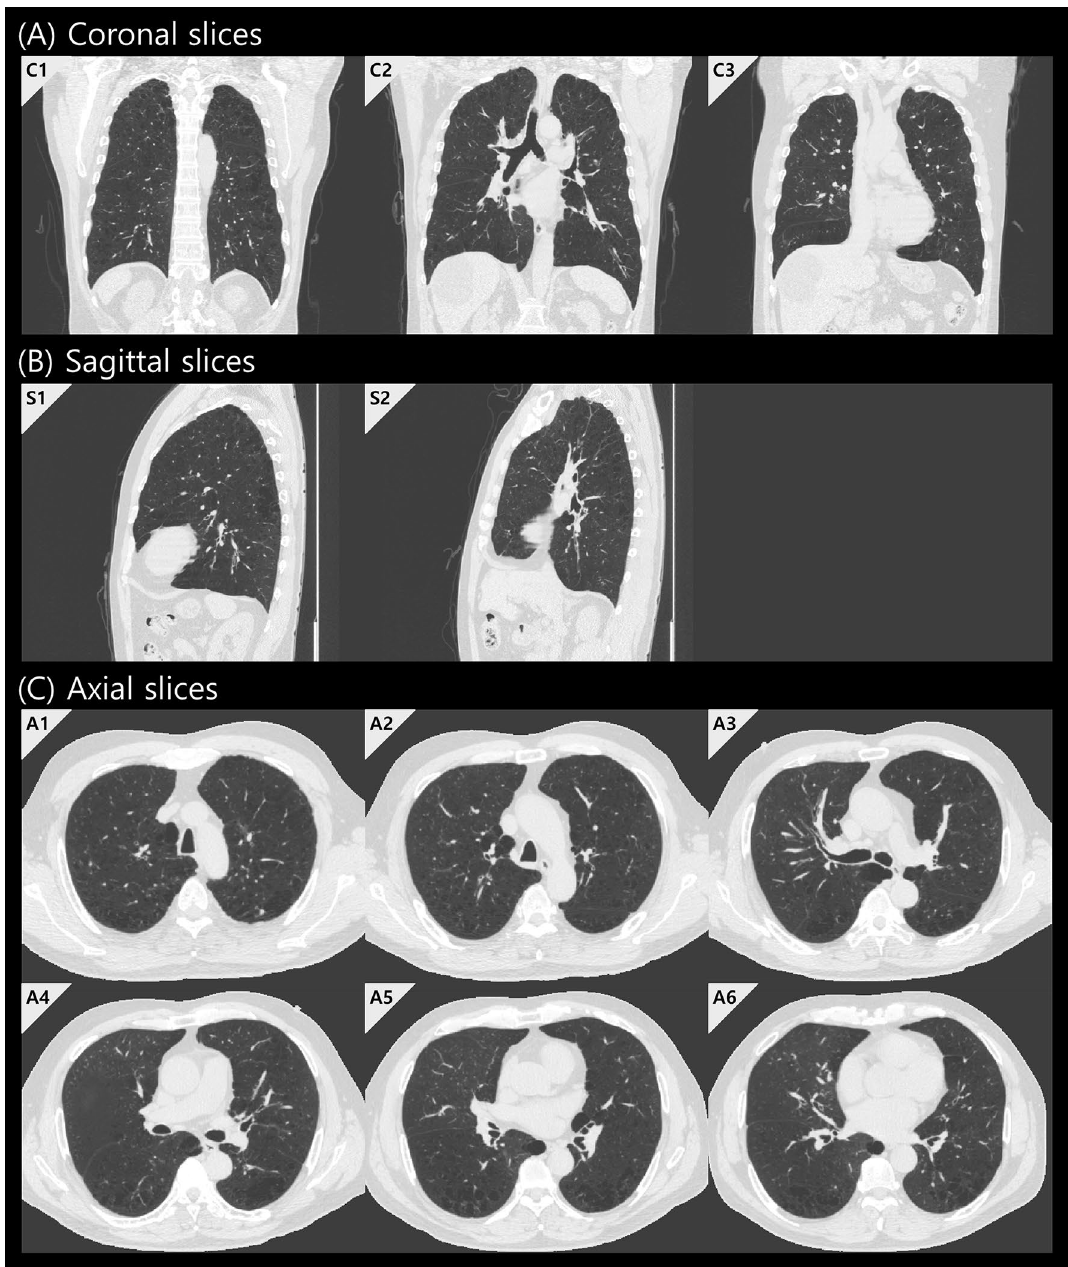
Figure 2. Convolutional neural network (CNN) model input to extract deep features. To extract deep features, 11 computed tomography slices were selected for CNN model input based on predetermined anatomic landmarks. ( A ) Coronal slices at the vertebral body (C1), center of the tracheal carina (C2), and superior vena cava (C3). ( B ) Sagittal slices at the center of the left (S1) and right (S2) lung. ( C ) Axial slices at two upper slices (A1, A2), center slice (A3), and three lower slices (A4, A5, A6) at 2-cm intervals at the center of the tracheal